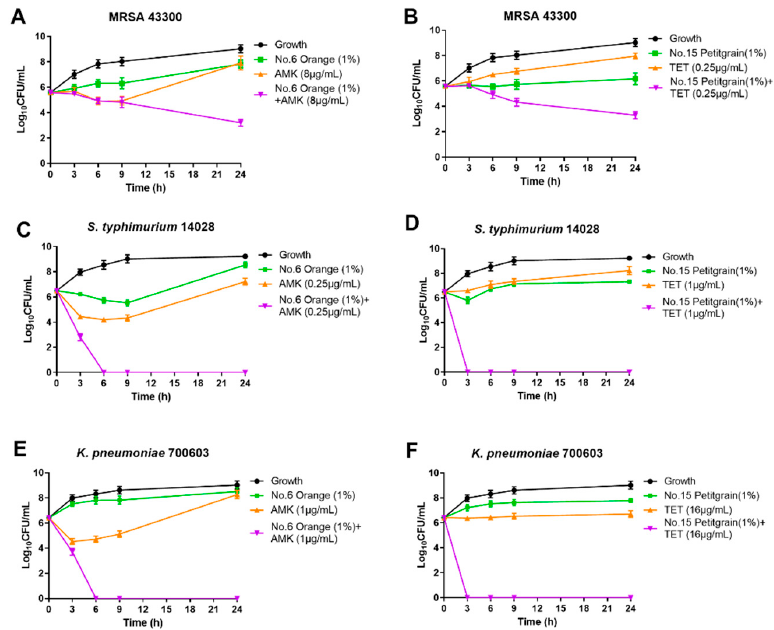
Figure 3. Time-kill curves of combinations of orange (1%) and amikacin (1× MIC) against ( A ) MRSA 43300 ( C ) S. typhimurium ATCC 14028 and ( E ) K. pneumoniae ATCC 700603 and the combinations of Petitgrain (1%) and tetracycline (1× MIC) against ( B ) MRSA 43300 ( D ) S. typhimurium ATCC 14028 and ( F ) K. pneumoniae ATCC 700603.